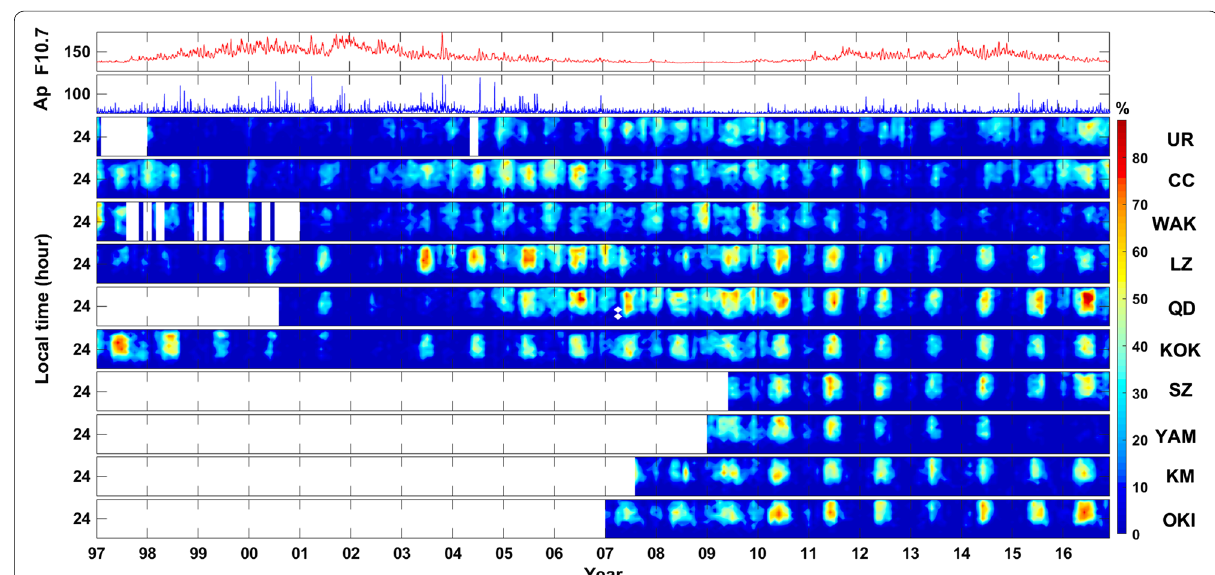
Fig. 2 Variations in daily F10.7, Ap index and monthly mean of FSF occurrence percentages at the 10 stations; the x -axis is the year and the y -axis is the local time